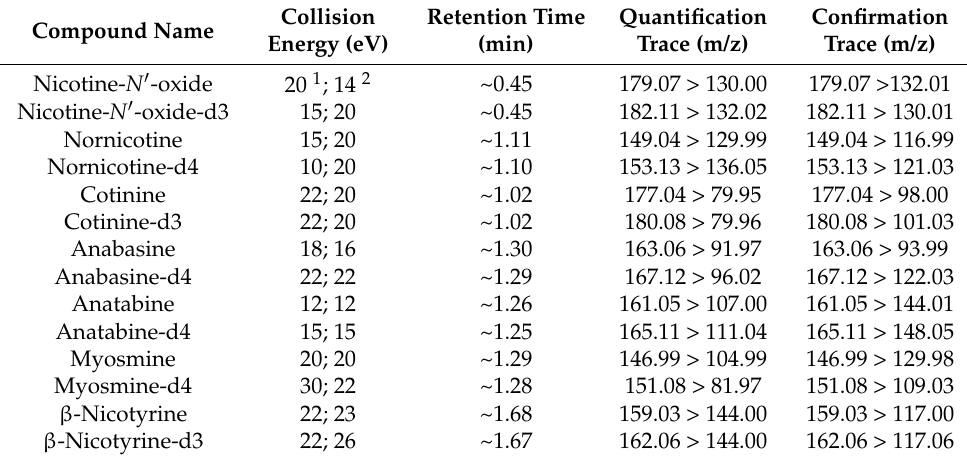
Table 1. Collision energies, retention times, quantification and confirmation